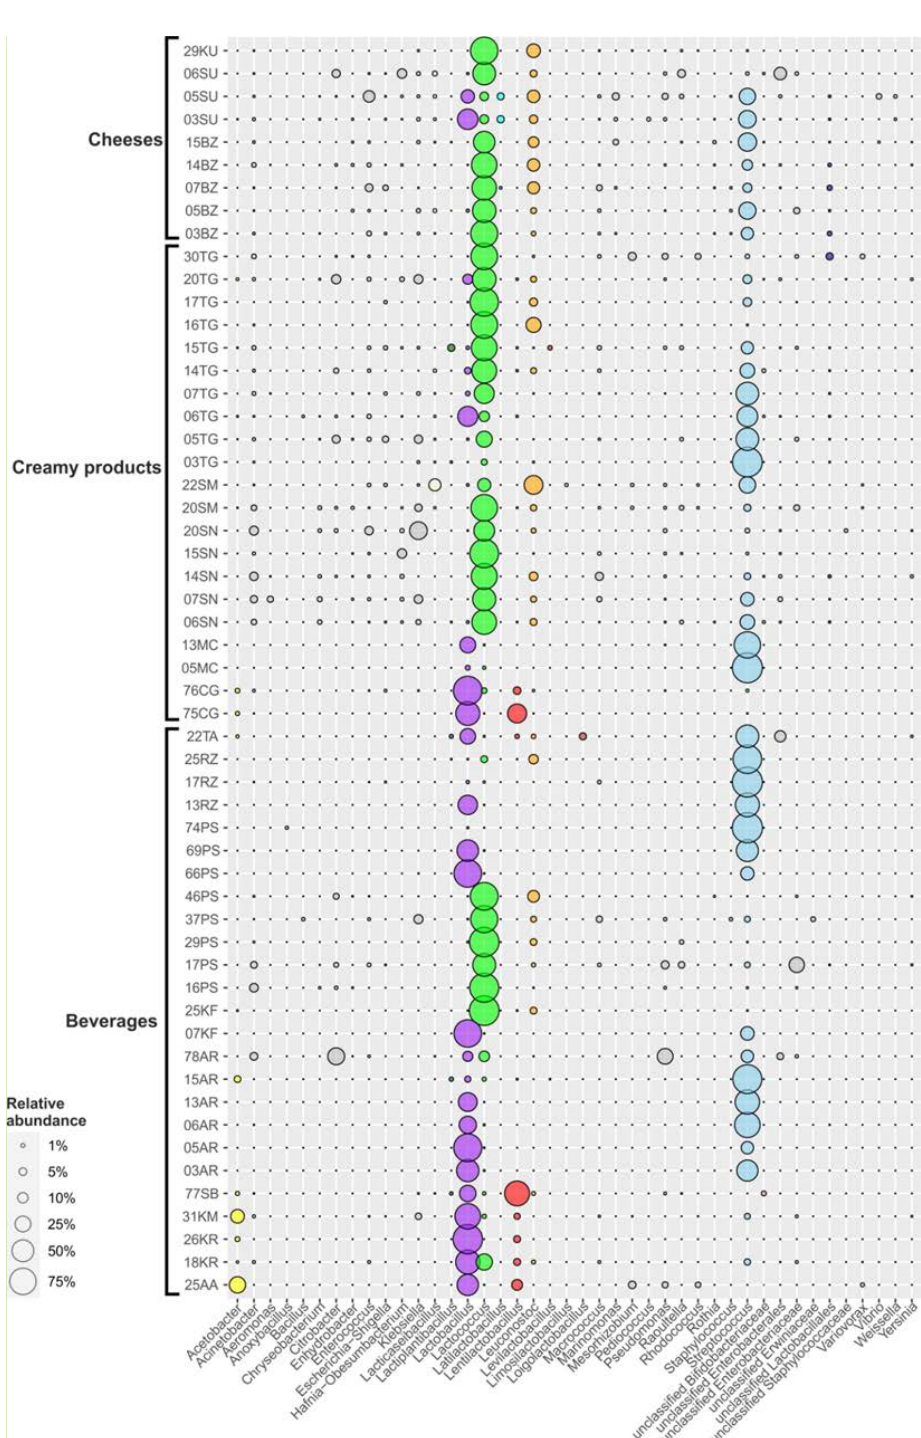
Figure 6. Diversity of bacterial genera found in microbiomes of studied fermented milk products. Only genera which made up ≥ 0.5% of total microbial community for at least one sample are shown. AA—aarts, AR—ayran, BZ—bryndza, CG—chegen, KF—kefir, KM—koumiss, KR— shubat, SN+SM—sour cream, SU—suluguni-like cheese, TA—tan and TG—cottage cheese.